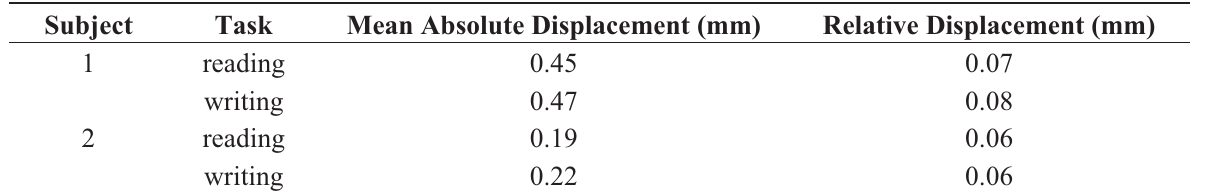
Table 1. Reading vs. writing